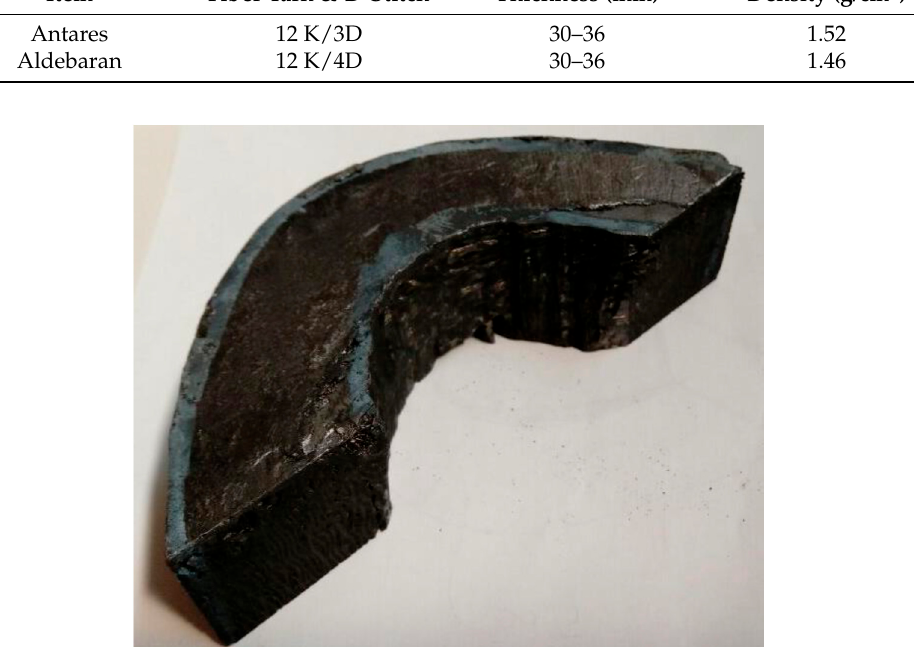
Figure 2. Chemical vapor infiltration (CVI)-produced C/C shell before the stabilization cycle.